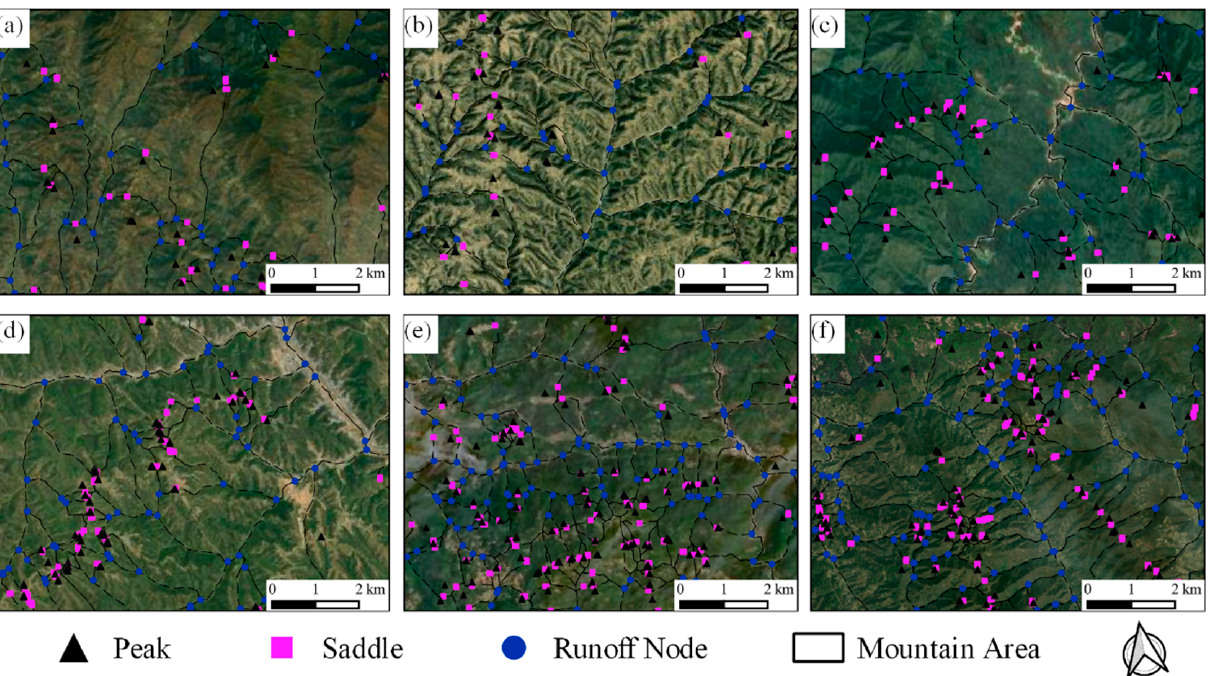
Figure 9. Validation of extracted point clusters by the optical image data: ( a – f ) correspond to six typical sample areas, including Hanyin, Mizhi, Ningshan, Yanchuan, Zhen’an and Zhenba County, respectively; the black triangles, purple squares and blue dots represent peaks, saddles and runoff nodes, respectively.